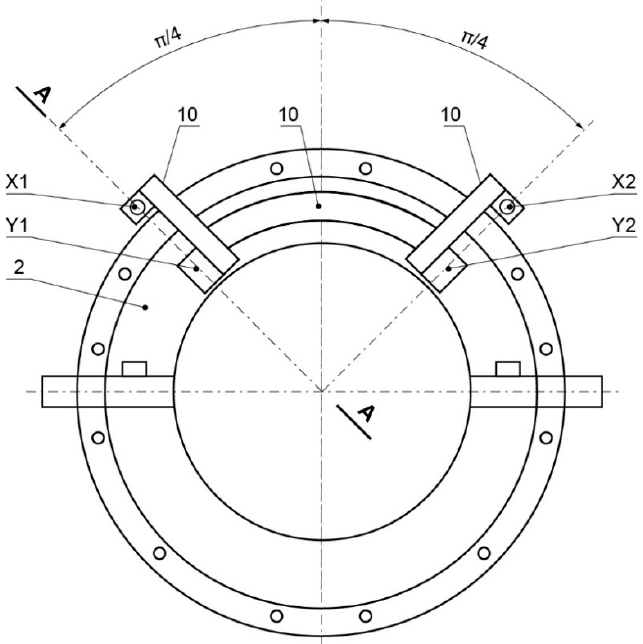
Figure 20. The engine cover with the mounted head: 10—head; 2—engine cover on the flywheel side; X1, X2—sensing element of eddy current sensors for axial measurements; Y1, Y2—sensing element of eddy current sensors for radial measurements.